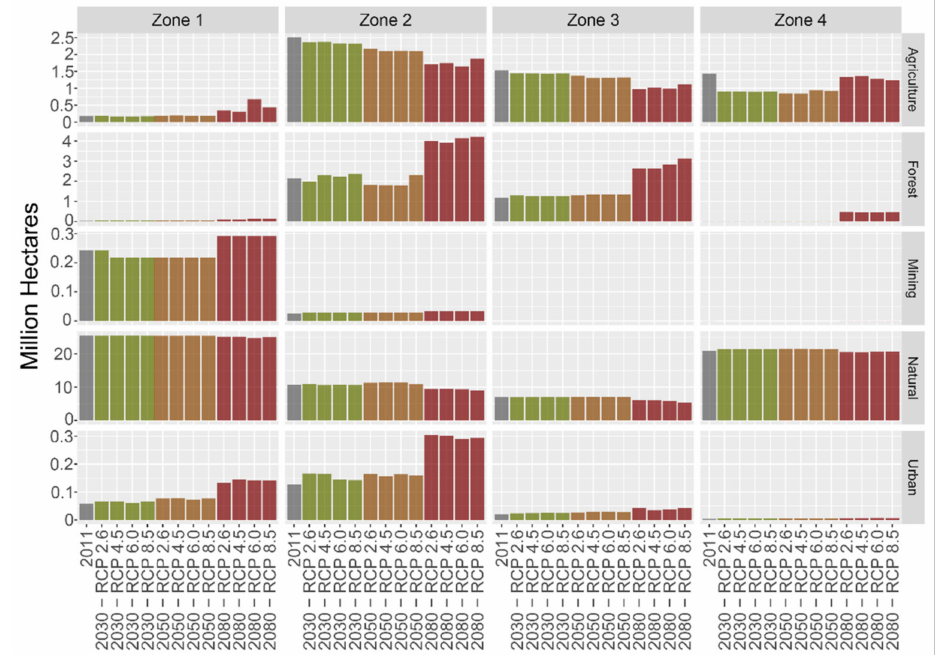
Figure 6. LULC trajectories for the years 2011, 2030, 2050, and 2080 for RCP 2.6, 4.5, 6.0, and 8.5 scenarios by geographic